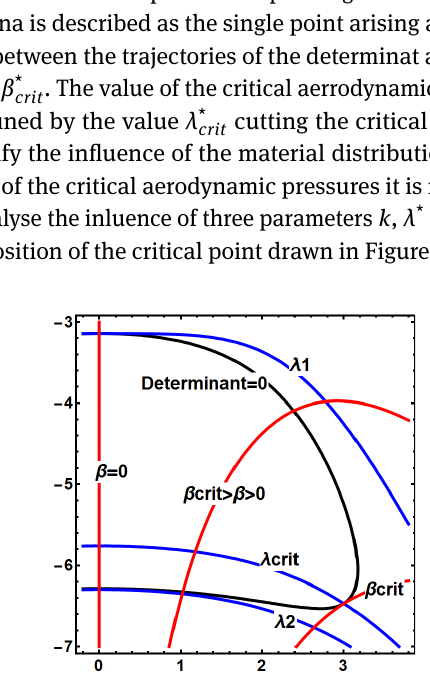
Figure 4: Evaluation of natural neighbourhood frequencies and critical (flutter) pressure (simply supported edges).